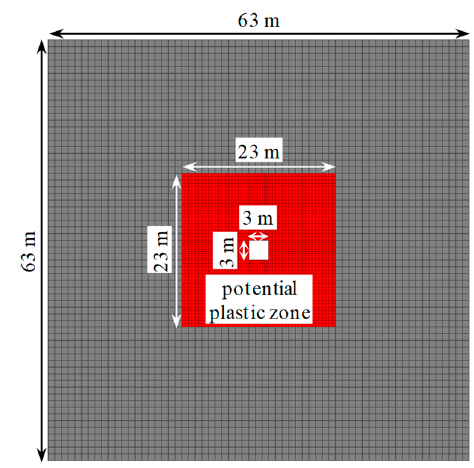
Figure 6. Model size and mesh.